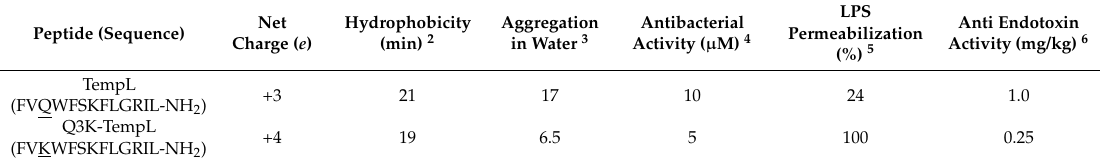
Table 1. Sequences and properties 1 of TempL and of the Q3K Table 1: Sequences and properties 1 of TempL and of the Q3K analog.